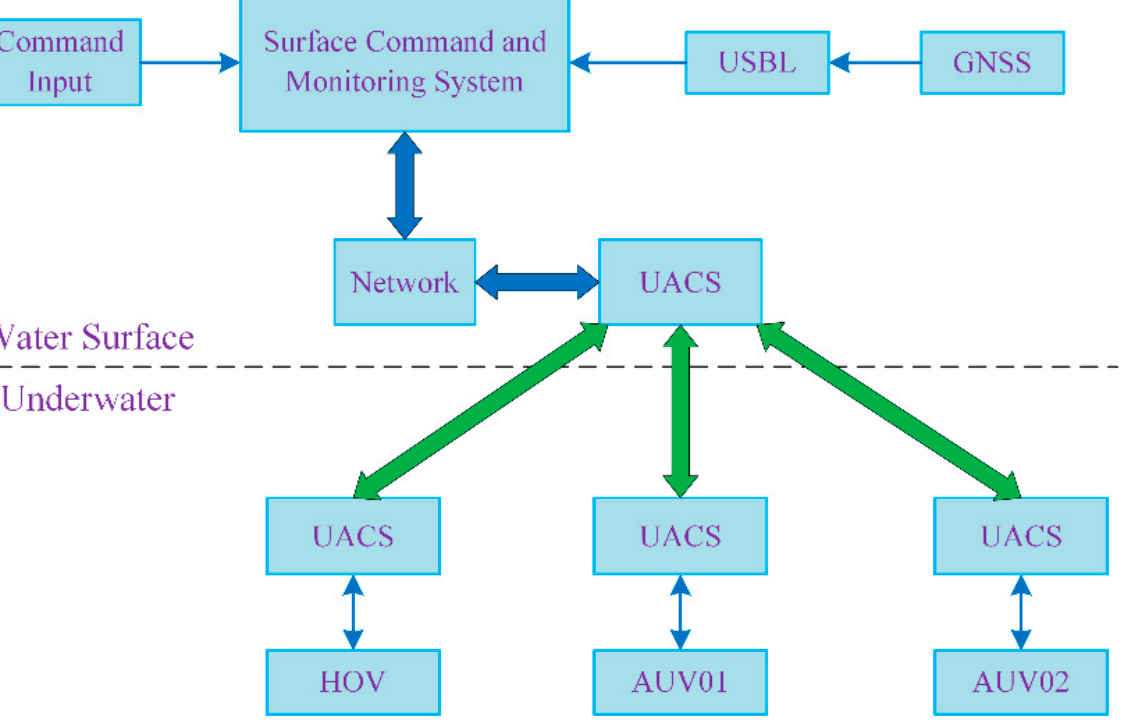
Figure 5. Information flow of a cooperative operation based on the pure research vessel R/V.